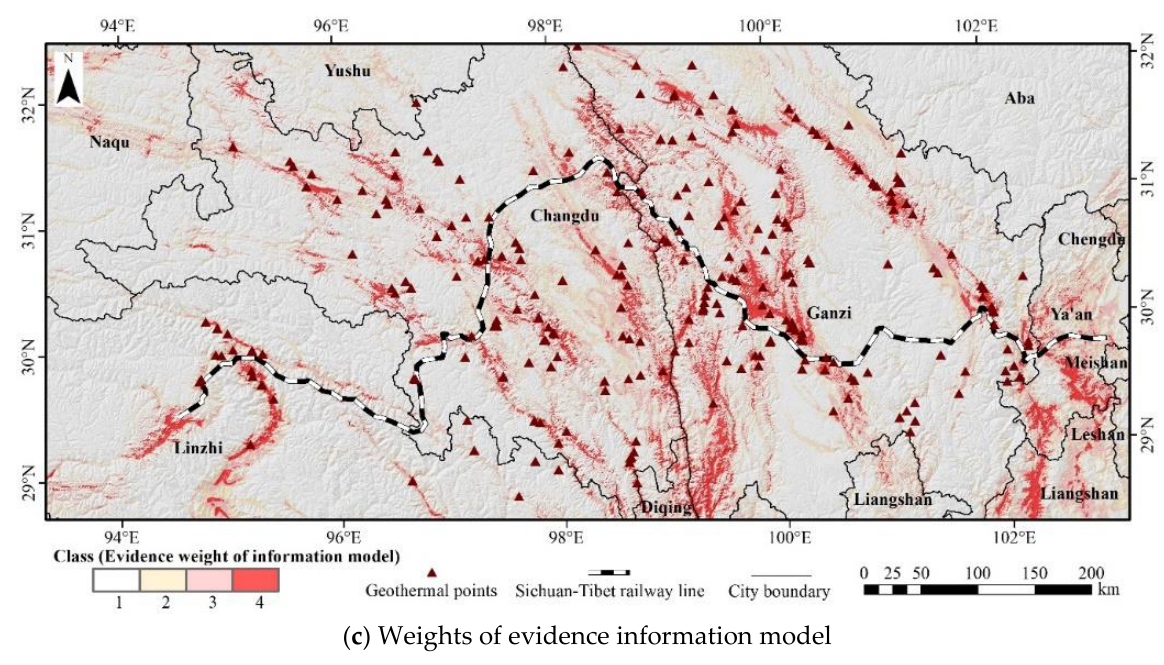
Figure 7. Classification maps of prediction.